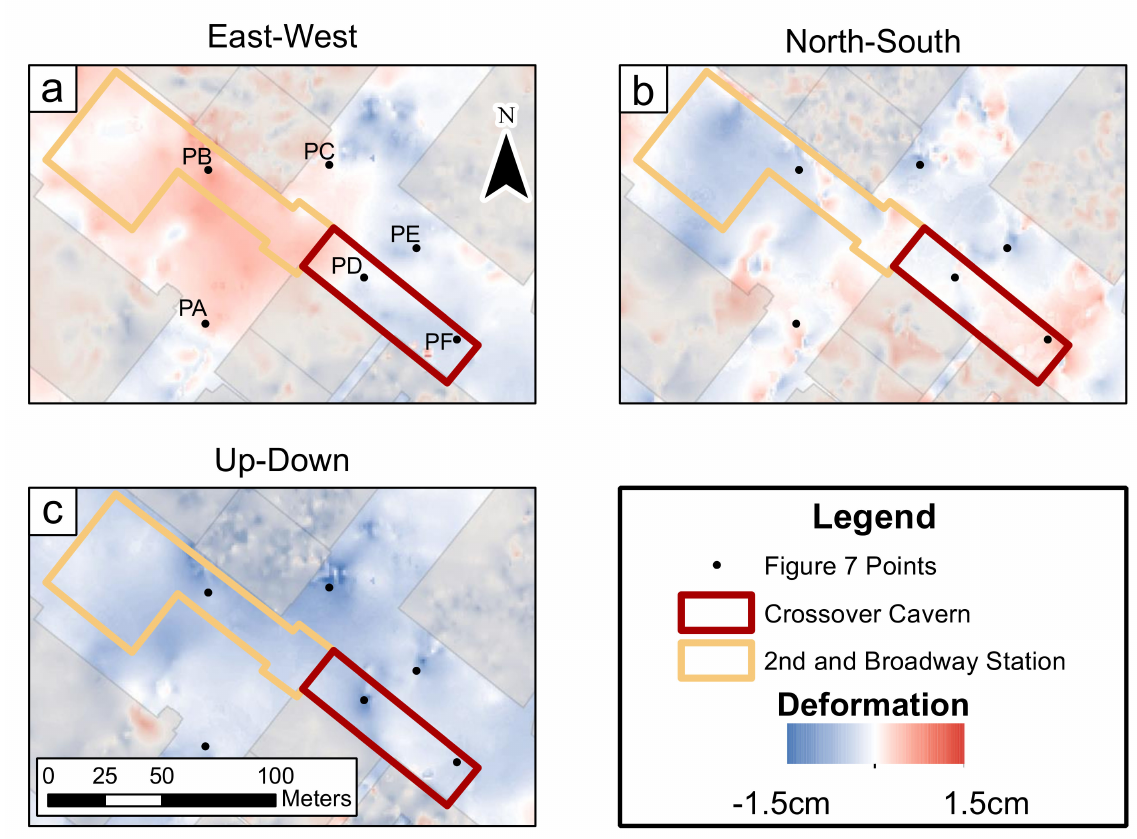
Figure 6. Map of surface deformation calculated from InSAR data spanning 16 November 2018 to 21 February 2019 in